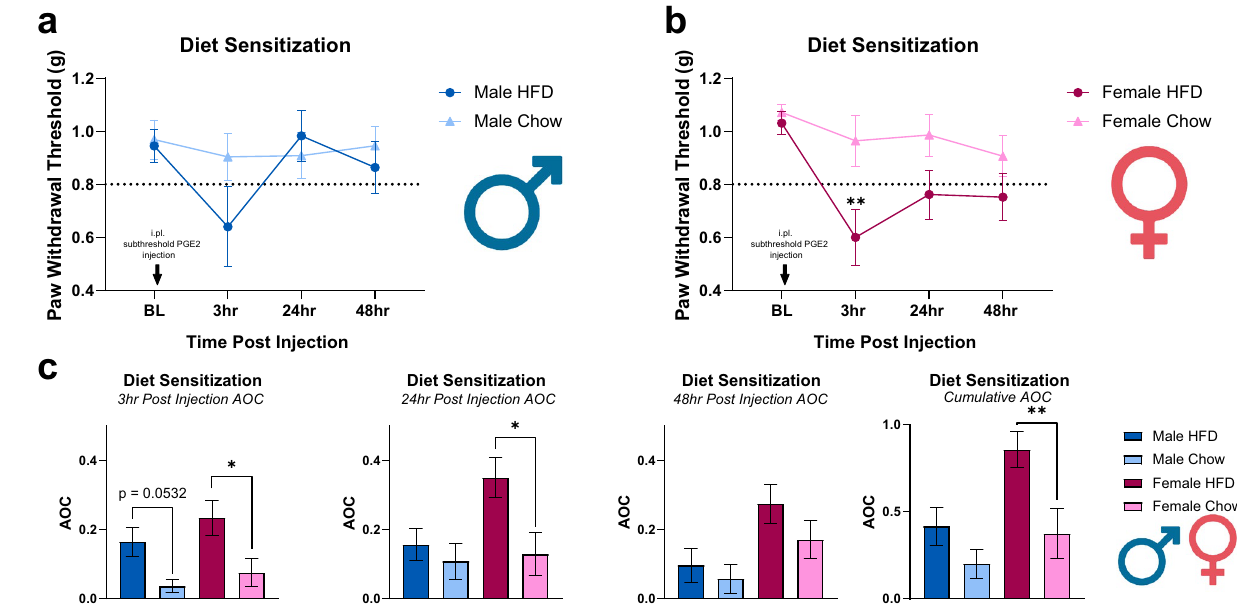
Figure 2. A short-term HFD regime causes diet sensitization. Mice received intraplantar injections of subthreshold dose of PGE 2 on week 8. ( a , b ) HFD males (n = 10) and females (n = 11) showed a decrease in paw withdrawal threshold post subthreshold PGE 2 injection compared to chow males (n = 11) and females (n = 10), respectively. **p < 0.01 (Two-Way ANOVA with Sidak’s post hoc comparison ( c ) area over the curve (AOC) for each time point showed that the three-hour time point elicited the largest response to a subthreshold dose of PGE 2, specifically in females. *p < 0.05 (Two-way ANOVA with Sidak’s post hoc comparison). Total AOC showed females significantly sensitized to the HFD compared to chow females. **p < 0.01 (Two-way ANOVA with Sidak’s post hoc comparison).